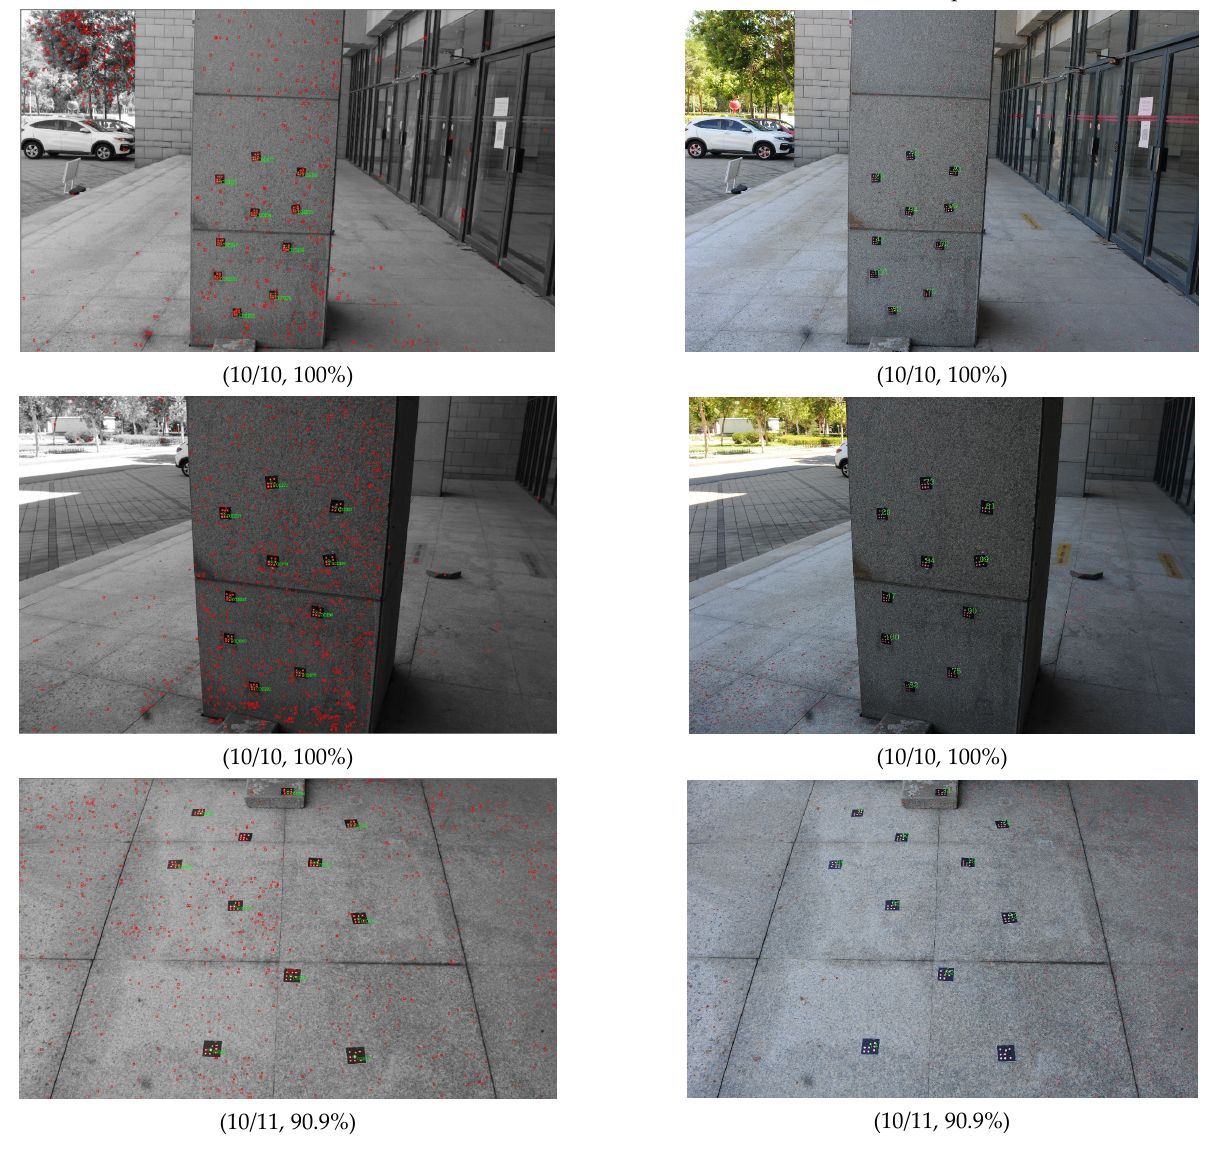
Figure 9. Experiment for outdoor scenes. The second column represents the count of GCTs con ‐ tained in the image. in the